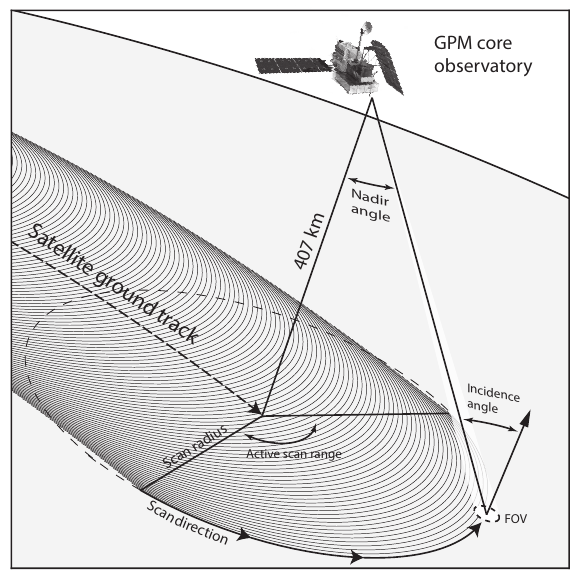
Figure 1. Schematic depiction of the scan geometry of the GMI. The dashed circle represents the instantaneous intersection of the cone of constant incidence angle with the Earth’s surface. Its radius and other characteristic parameters are given in Table